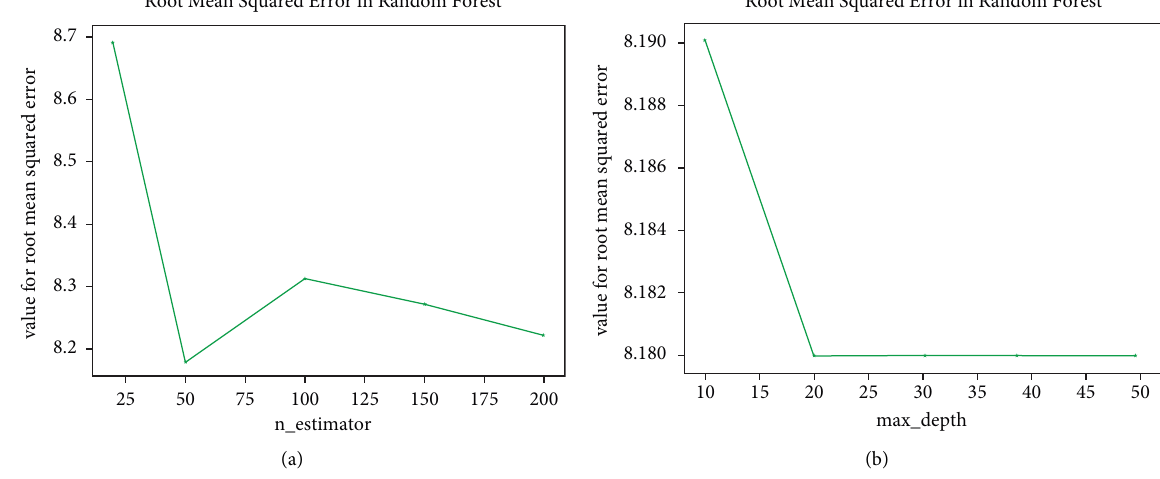
Figure 8: RMSE of random forest algorithm: (a) n_estimator and (b) max_depth